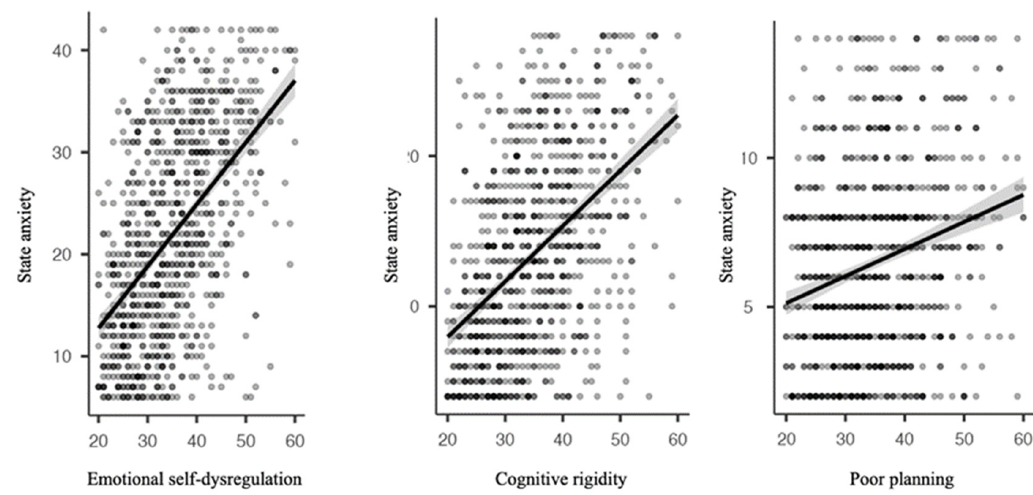
Figure 4. Correlations between state anxiety and each of the executive functioning dimensions.